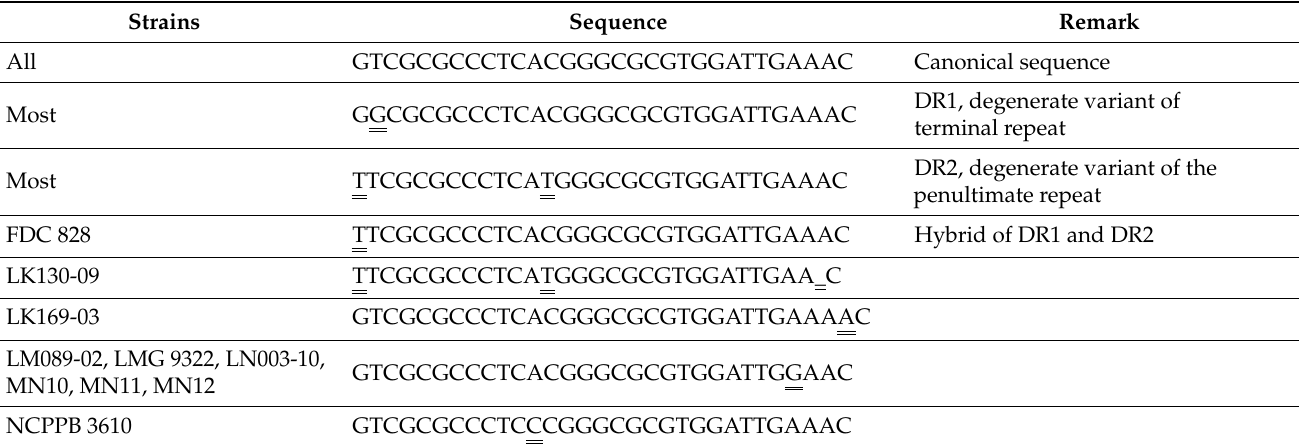
Table 4. Variant DR sequences in X. citri pv. citri